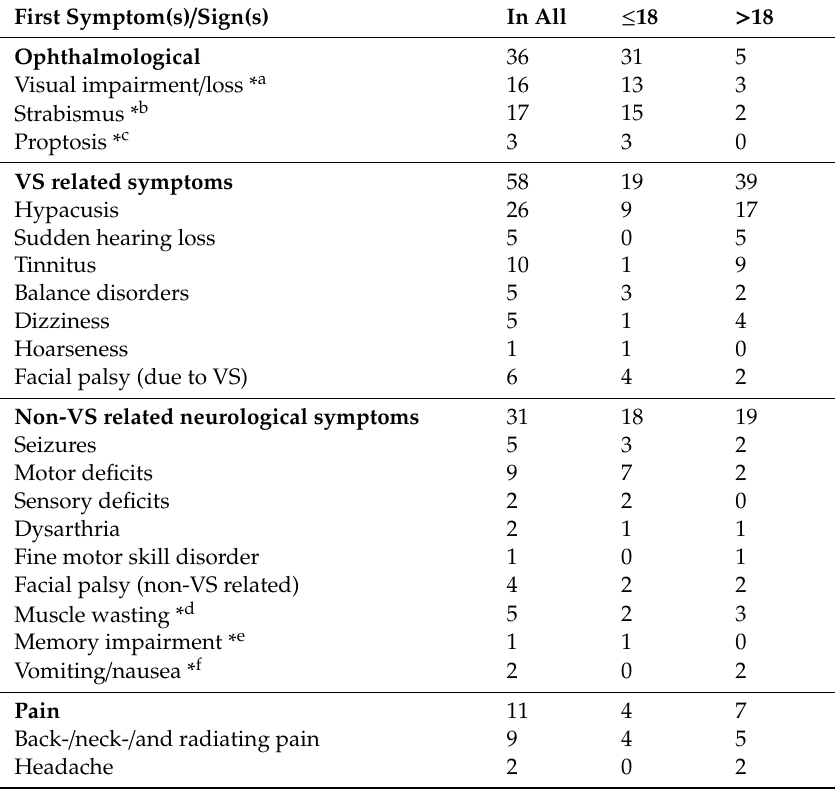
Table 2. Details of presenting symptom(s) of 106 patients with